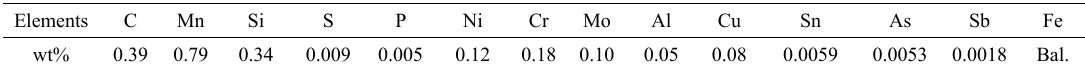
Table 1. Chemical composition of Al-killed AISI 1040 steel ( in % wt. ).